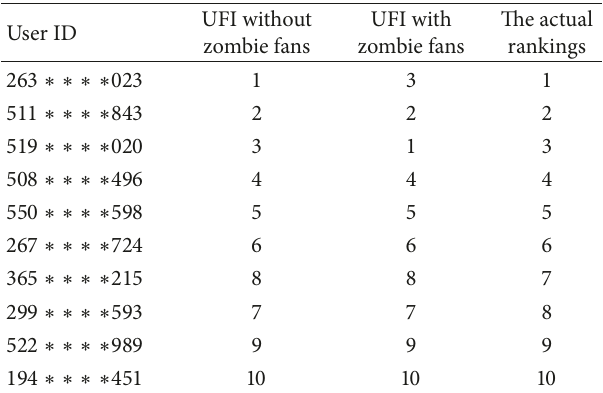
Table 7: Comparison of the user final influence.